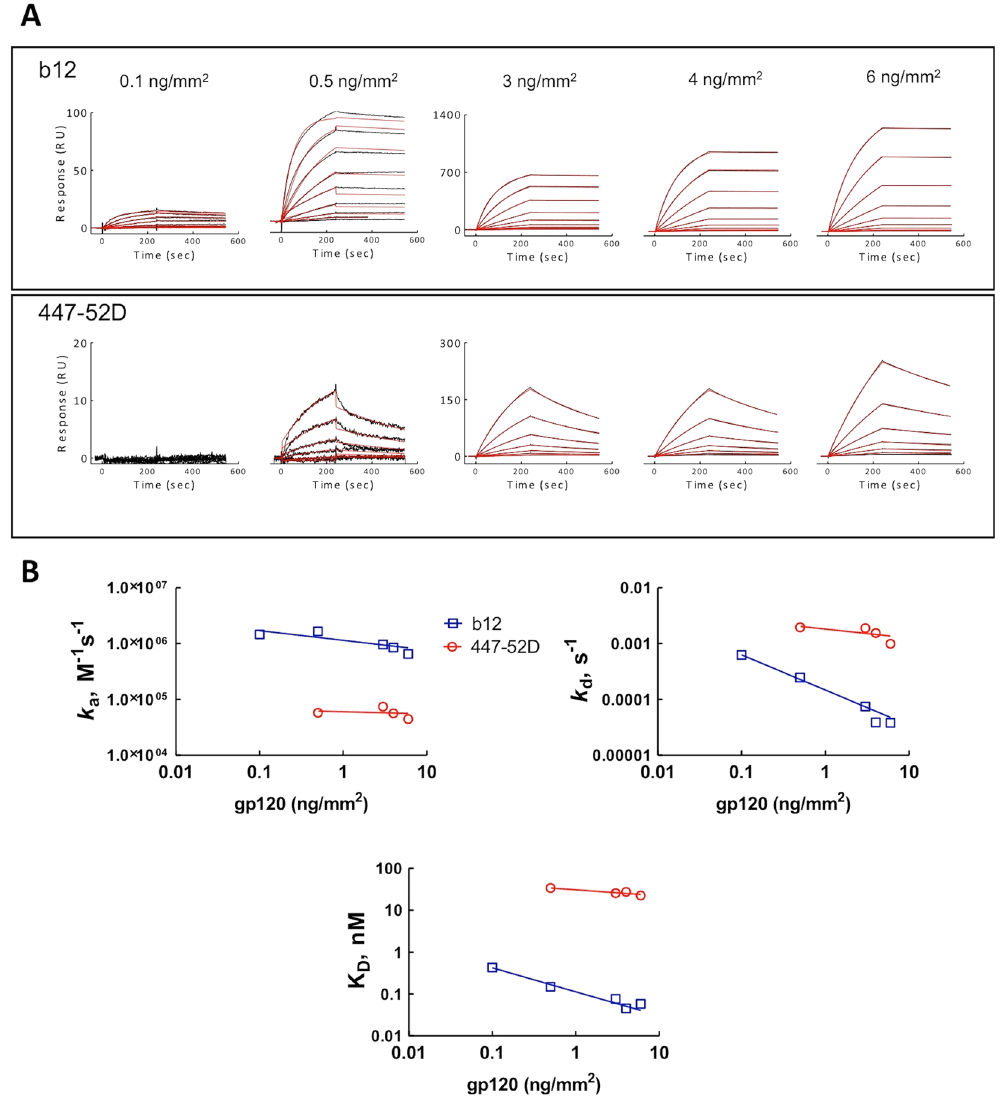
Figure 1. ( A ) Real time interaction profiles of Abs b12 and 447-52D as a function of immobilized density of gp120 (HIV-1 IIIB). The black line depicts the binding profiles obtained after injection of serial dilutions of b12 (25–0.048 nM) and 447-52D (50–0.097 nM). The red lines depict the fits of data obtained by global analyses using Biaevaluation software. The measurements were performed at 25 °C. ( B ) Effect of density of surface immobilized gp120 IIIB on the association rate constant; dissociation rate constant, and equilibrium dissociation constant of b12 (blue lines and symbols) and 447-52D (red line and symbols). The binding kinetics was assessed at 25